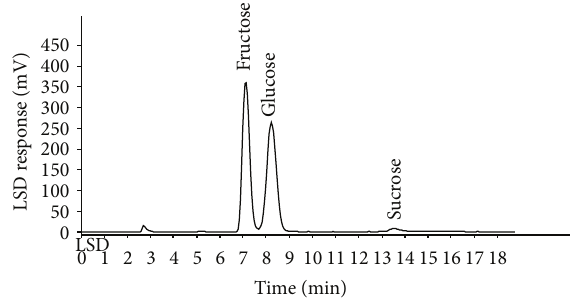
Figure 2: HPLC-ELSD profile of a sample of goji